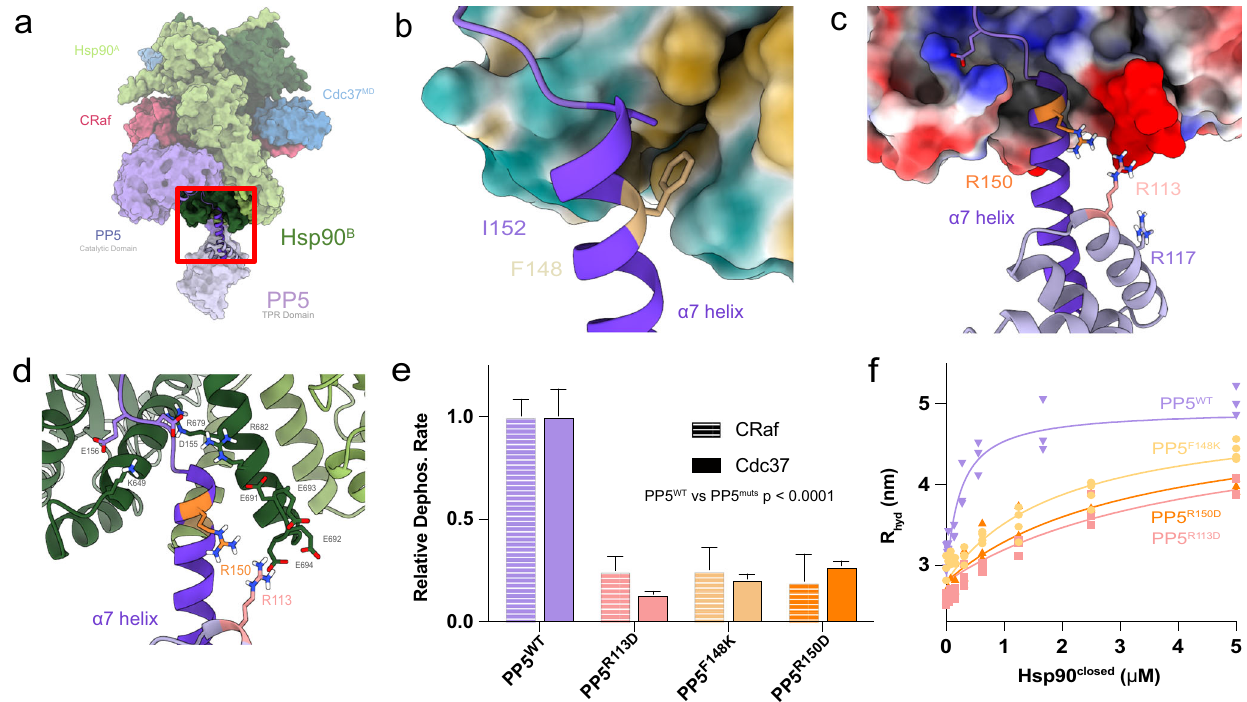
p <0.0001; Cdc37: n mutants =3, n WT =4, p <0.0001) with a Dunnett test for